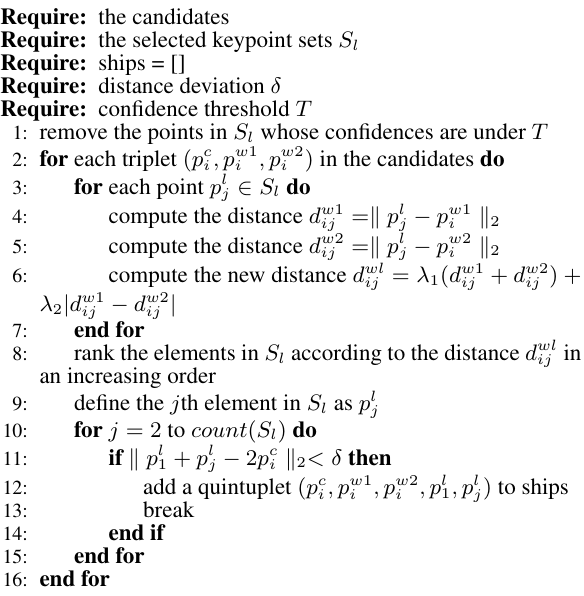
Algorithm 2 End Keypoint Clustering